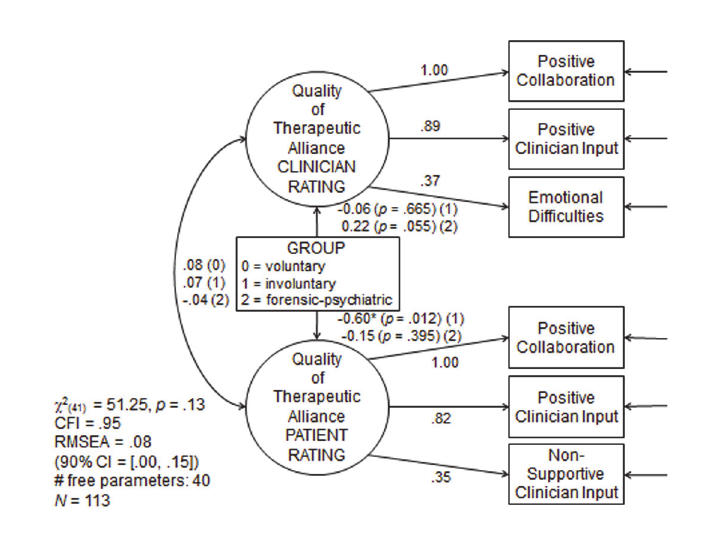
Fig 2. Structural Equation Modeling (SEM). Based on a comparative fit index (CFI) of 0.95 and using the method of power estimation for SEM[23][23][33][33] [33], we estimated the achieved power of the SEM model to be only. 275 only. We used the covariance matrix of the reference group (i.e., the self-referred general psychiatric patients) as a basis for the estimation of achieved